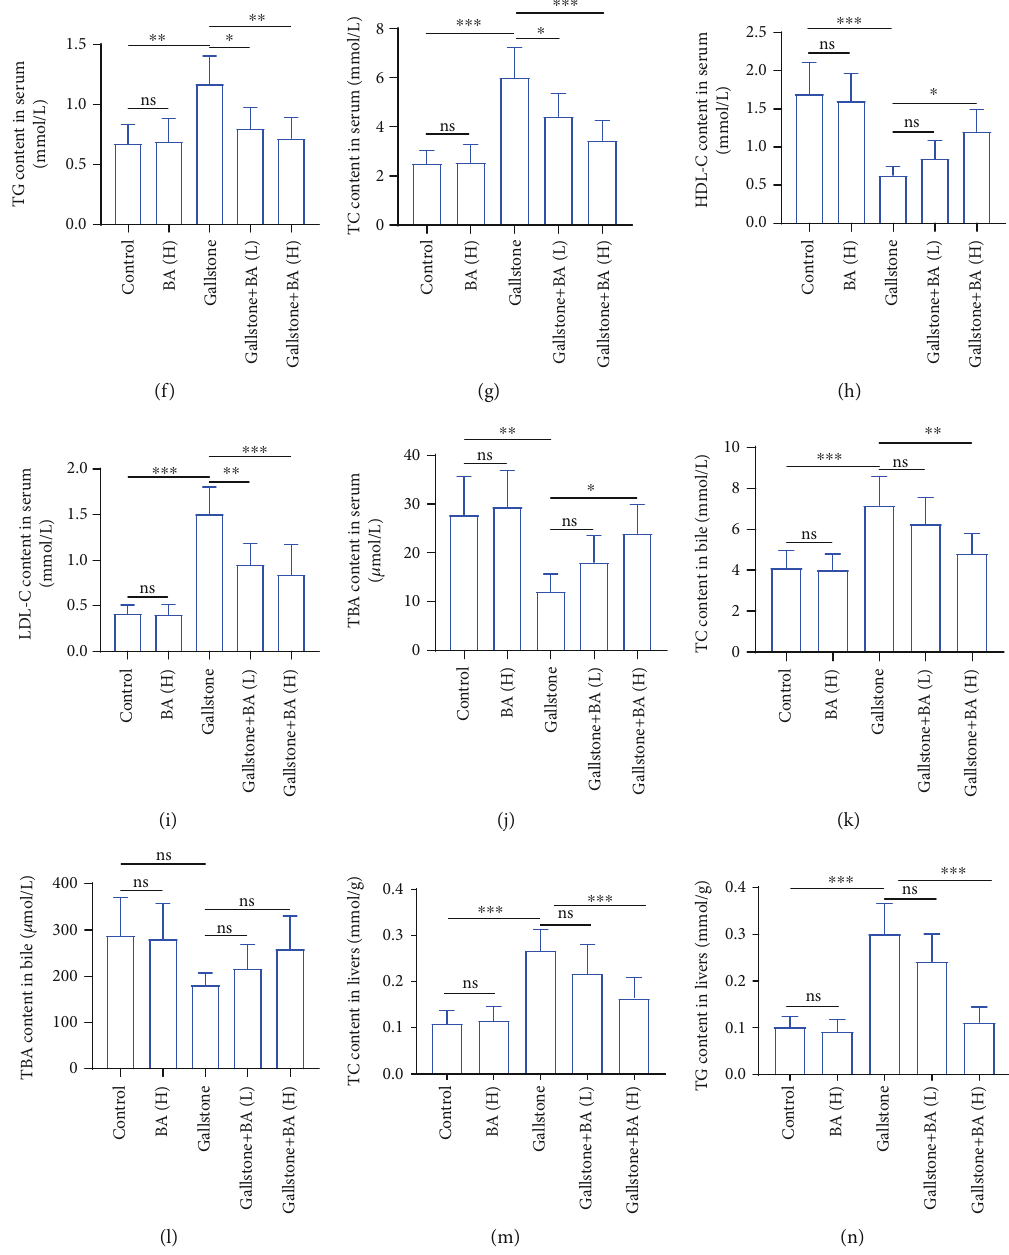
Figure 2: Baicalin alleviated lithogenic diet-induced gallstone and hyperlipidemia in mice. (a) Body weight was recorded and calculated in the mice, which received a lithogenic diet or/and Baicalin treatment. n = 6 . (b, c) The representative pictures of the gallbladder of mice with a lithogenic diet or/and Baicalin administration (the arrows indicate the gallbladder). The gallstone positive rate of mice is shown in each group. n = 12 . (d) The weight of gallbladders was calculated. (e) HE staining was performed to detect the pathological and physiological characteristics of gallbladder tissues (the scale bar represented 100 μ m). (f – j) The content of triglyceride (TG) (f), total cholesterol (TC) (g), high-density lipoprotein cholesterol (HDL-C) (h), low-density lipoprotein cholesterol (LDL-C) (i), and total bile acid (TBA) in serum (j) of mice in each group. (k, l) The content of TC (k) and TBA (l) in bile of mice in each group. n = 6 . (m, n) The content of total cholesterol (TC) (m) and triglyceride (TG) (n) in the liver of mice in each group. n = 6 ( ∗ p < 0 : 05 , ∗∗ p < 0 : 01 , and ∗∗∗ p < 0 : 001 ). ns: no signi fi cance; BA(L): 50mg/kg baicalin; BA(H): 100mg/kg